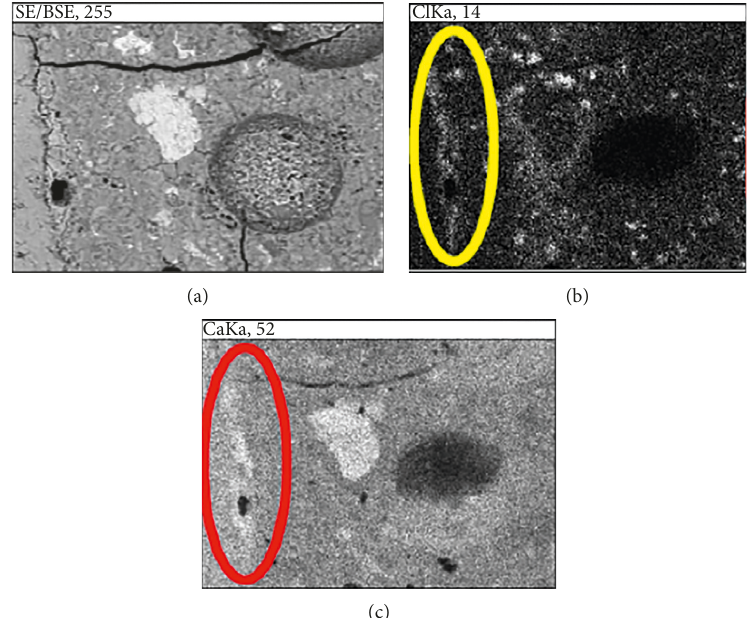
Figure 4: SEM map analysis on distressed samples under cyclic freeze thaw in CaCl